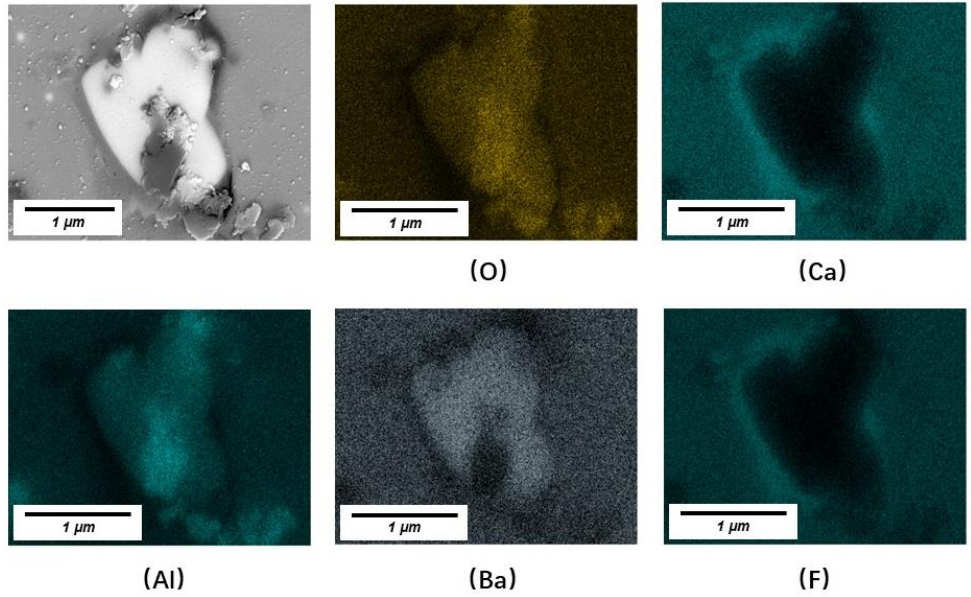
Figure 7. Backscattered SEM image and EDS area scanning of LiAlO 2 and LiAlO 2 cores for the precipitation of BaAl 2 O 4 in the film solidified in molten slag at 1300 ◦ C.